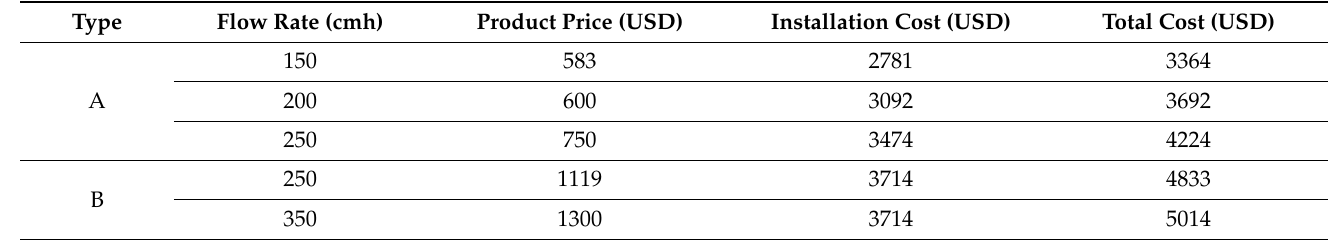
Table 2. Product and installation of ERV with respect to capacity (currency: USD 1 (cid:59) KRW 1200, as of 7 January